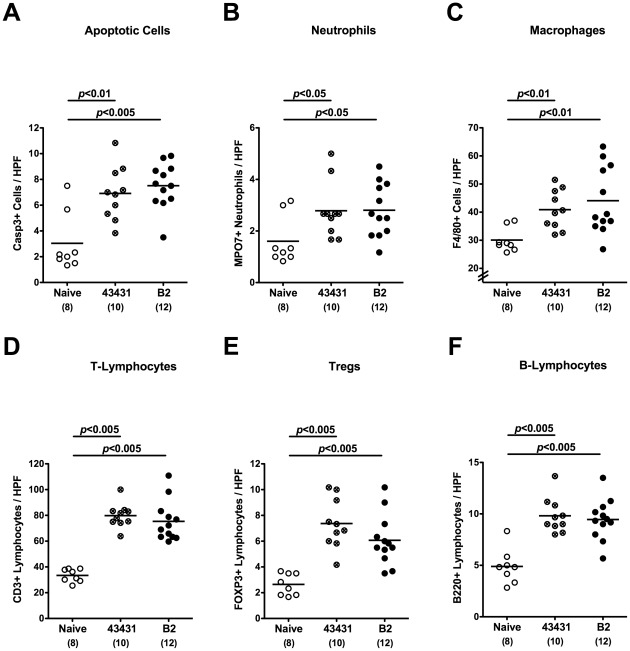
Inflammatory and immune cell responses following C. jejuni infection of infant mice.Conventionally colonized 3-weeks-old infant mice were orally infected with C. jejuni strain ATCC 43431 (crossed circles) or B2 (solid circles) as described in Methods. The average numbers of apoptotic cells (positive for caspase-3, panel A), neutrophilic granulocytes (neutrophils, positive for MPO-7, panel B), macrophages (positive for F4/80, panel C), T-lymphocytes (positive for CD3, panel D), regulatory T-cells (Tregs, positive for FOXP3, panel E) and B-lymphocytes (positive for B220, panel F) from at least six high power fields (HPF, ×400 magnification) per animal were determined microscopically in immunohistochemically stained colon sections at day 6 p.i. Uninfected mice (Naïve, open circles) served as negative controls. Numbers of analyzed animals are given in parentheses. Means (black bars) and levels of significance (P-values) determined by the Student’s t-test are indicated. Data shown are representative for three independent experiments.